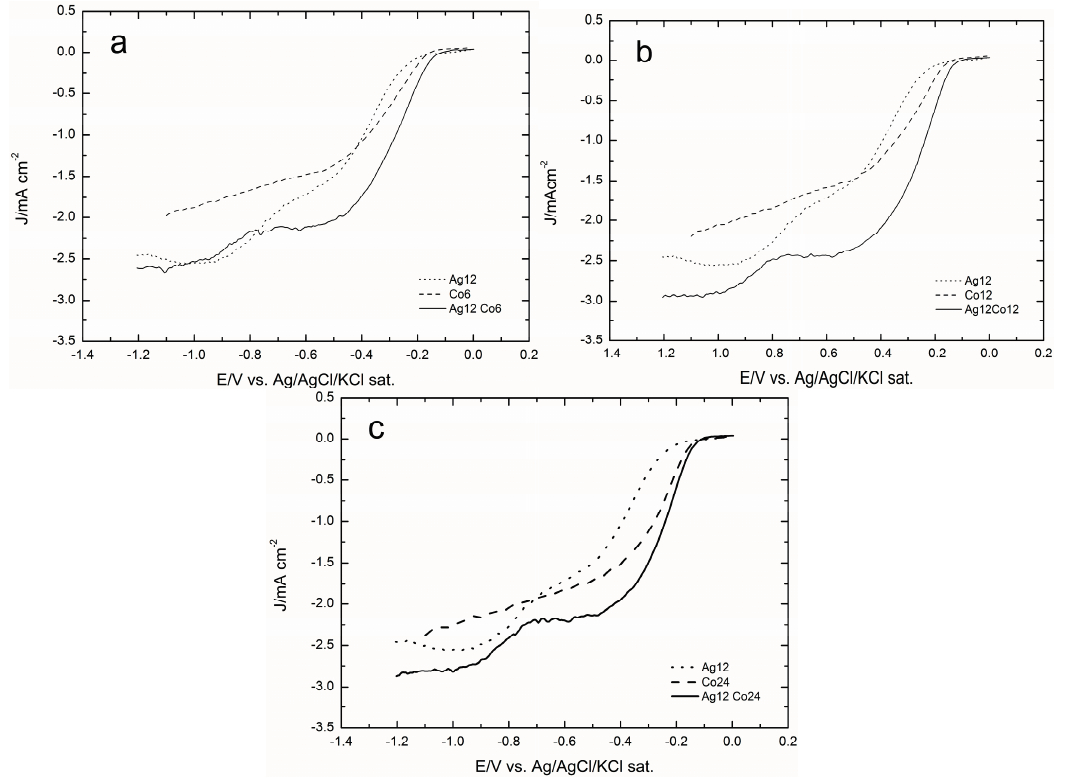
Figure 8. The oxygen reduction reaction (ORR) of the GC/Ag12Co samples and the corresponding GC/Co samples with the same amount of cobalt of ( a ) 6 mC, ( b ) 12 mC and ( c ) 24 mC are compared with the curve of the GC/Ag12 sample of [31]. All curves are recorded at 500 rpm with a scan rate of 50 mV·s − 1 .